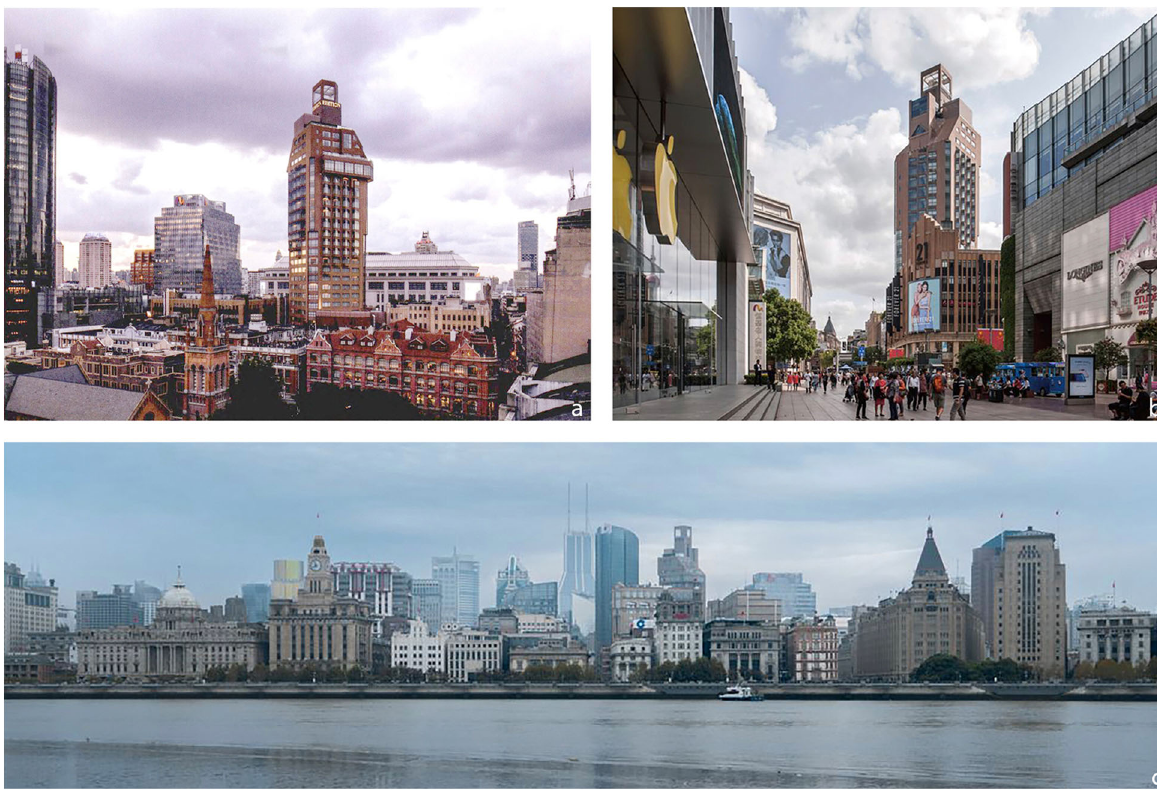
Fig. 13 SECEP Building in its urban context after renovation (2018) (Sources: a , b Fan 2018; c Peng and Dong 2018)